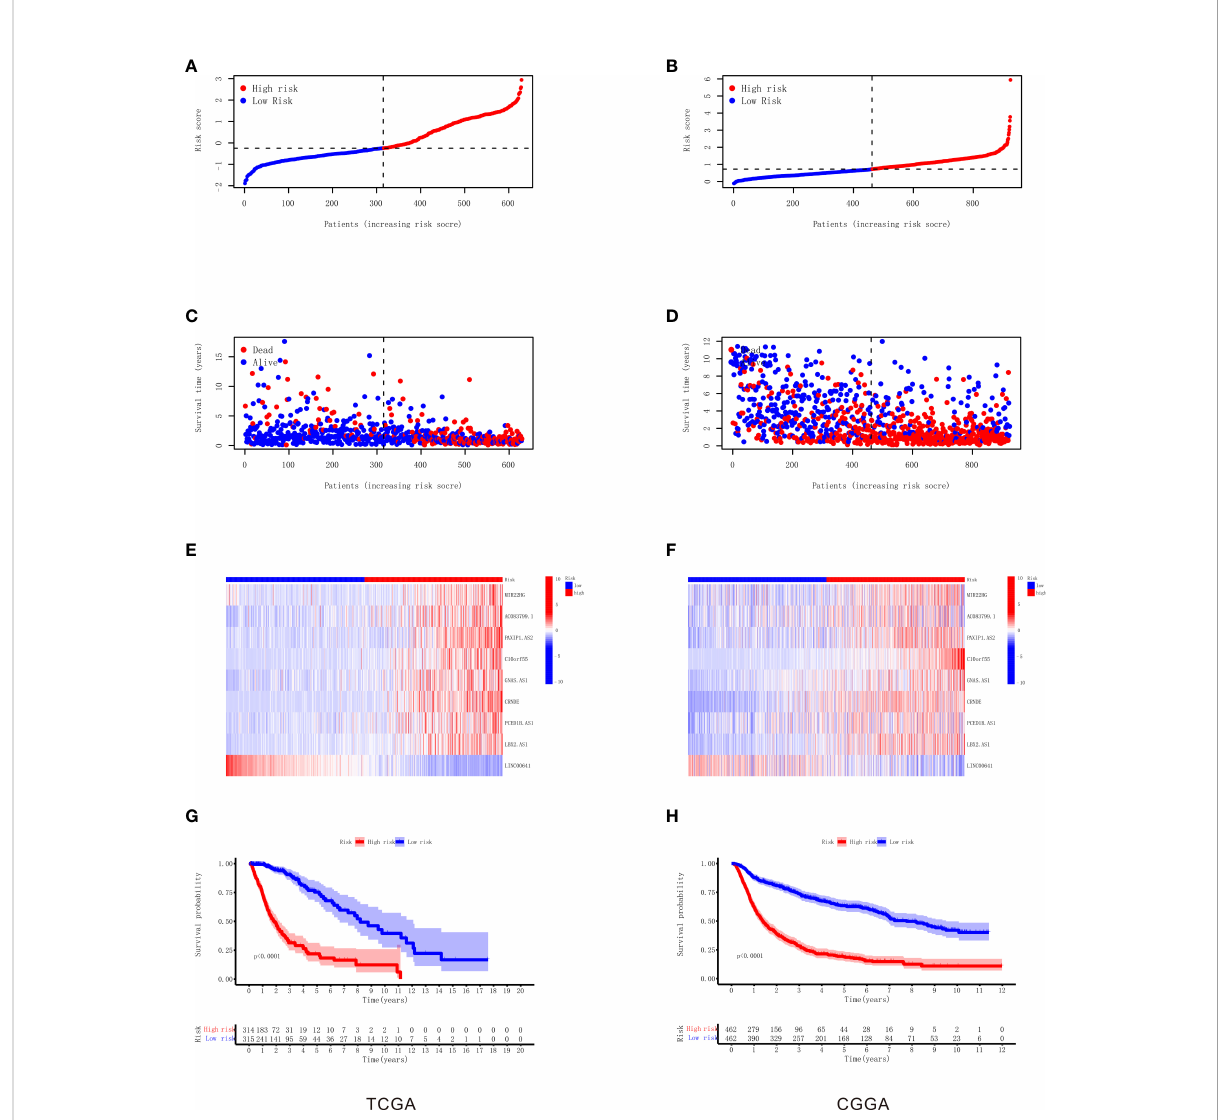
FIGURE 3 Construction and validation of the nine necroptosis-related lncRNA signatures for survival prediction. (A) The distribution of each sample based on the risk score in TCGA. (B) The distribution of each sample based on the risk score in CGGA. (C) The scatterplot based on the survival time and status of each sample in TCGA. The red and blue dots represent dead and alive, respectively. (D) The scatterplot based on the survival time and status of each sample in CGGA. The red and blue dots represent dead and alive, respectively. (E) The heatmap of nine necroptosis-related lncRNAs ’ expression levels in the high ‐ risk and low ‐ risk groups in TCGA. (F) The heatmap of nine necroptosis-related lncRNAs ’ expression levels in the high ‐ risk and low ‐ risk groups in CGGA. (G) Kaplan – Meier survival analysis of the high ‐ risk and low ‐ risk groups based on the